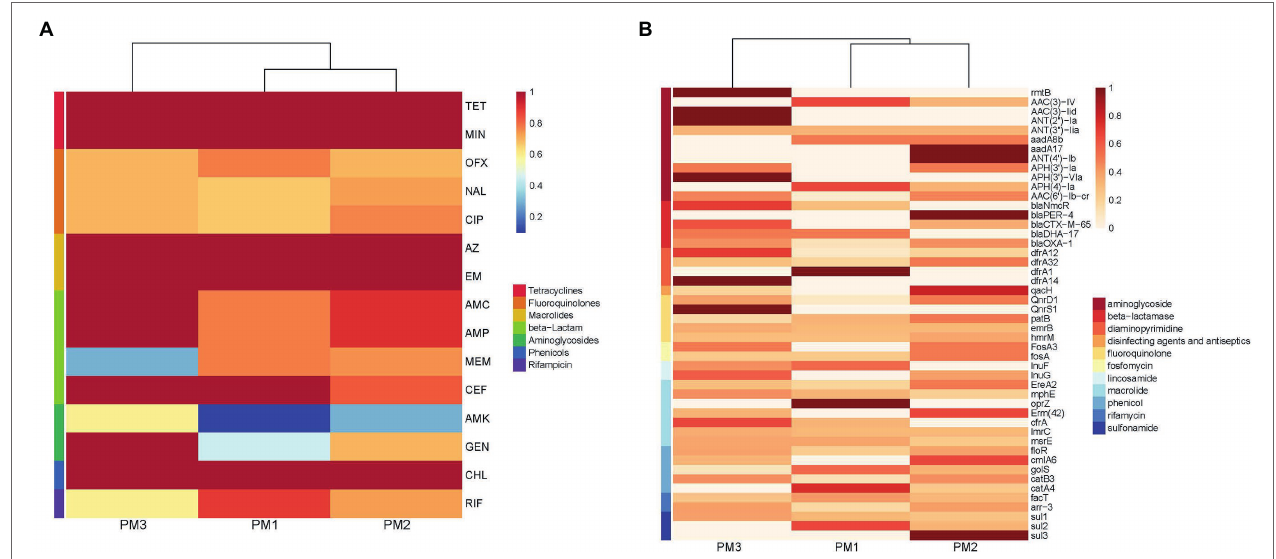
FIGURE 4 | Heatmap of antimicrobial resistance of P. mirabilis isolates according to (A) phenotype and (B) genotype.